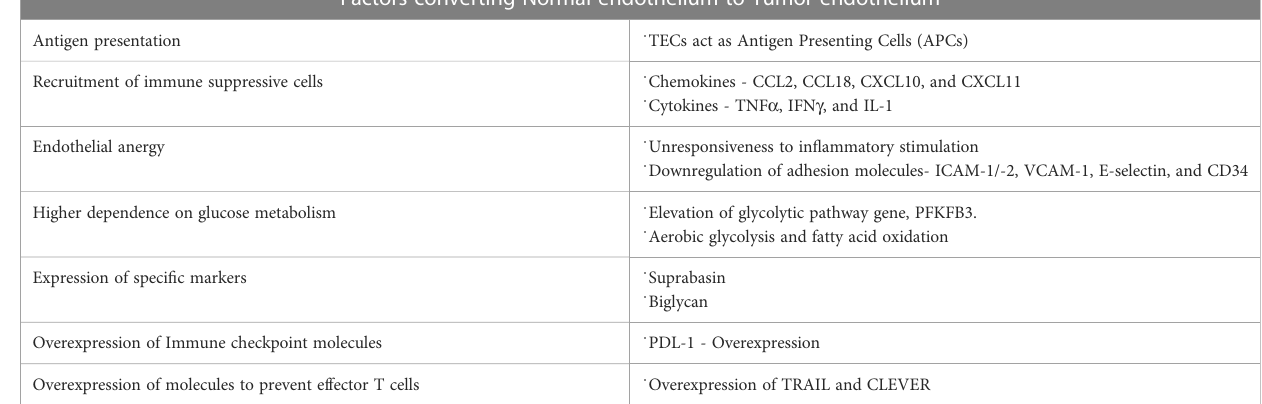
TABLE 1 Factors converting normal endothelium to tumor